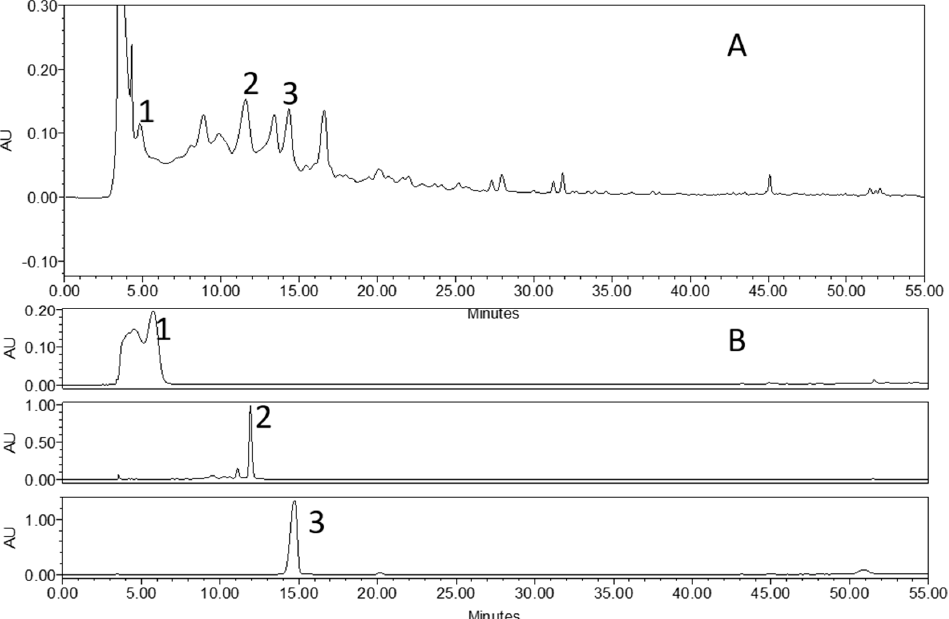
Figure 2. HPLC chromatograms of sweet potato extract and individual compounds: ( A ) Chromatogram of sweet potato extract; ( B ) chromatogram of standard compounds: (1) scopolin, (2) trifostigmanoside I, and (3) scopoletin.